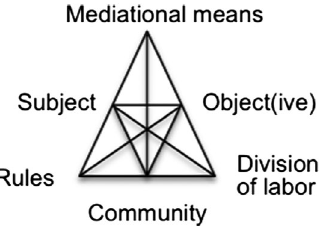
FIG. 1. A generalized activity theoretic triangle [48], which we use as the fundamental unit of analysis for UE-child interactions at PISEC. Lines indicate connections between